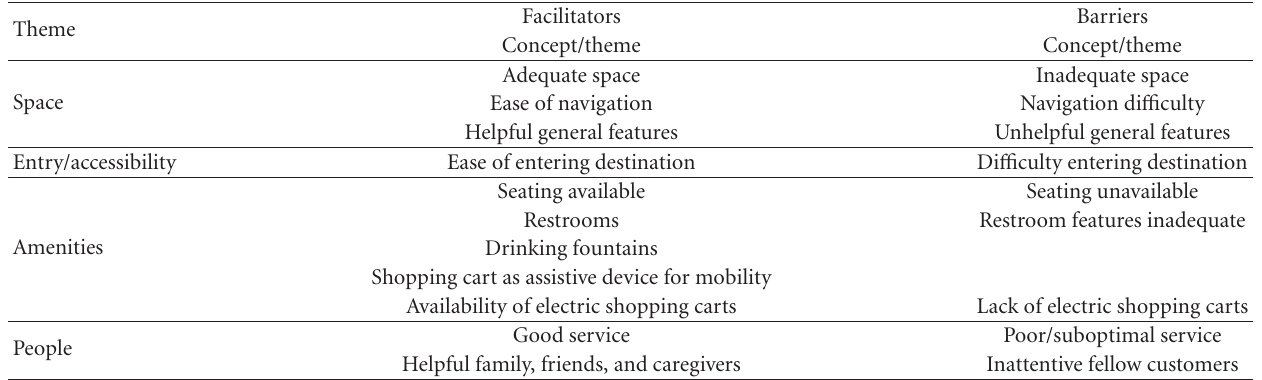
Table 3: Facilitators and barriers of food access